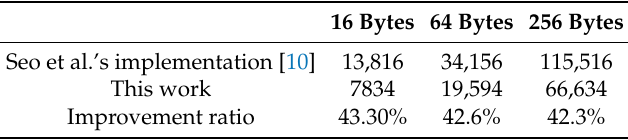
Table 3. Timing costs for GHASH function and comparison to previous work (timings are measured by clock cycles ( cc